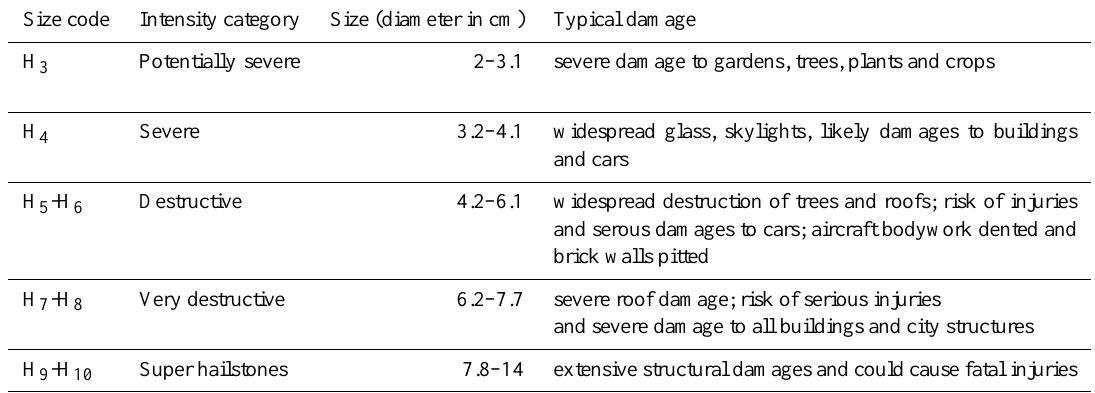
Table 2. An adjusted TORRO Hailstorm Intensity Scale (H3 to H10) for the GMSTWA hailstones. Size